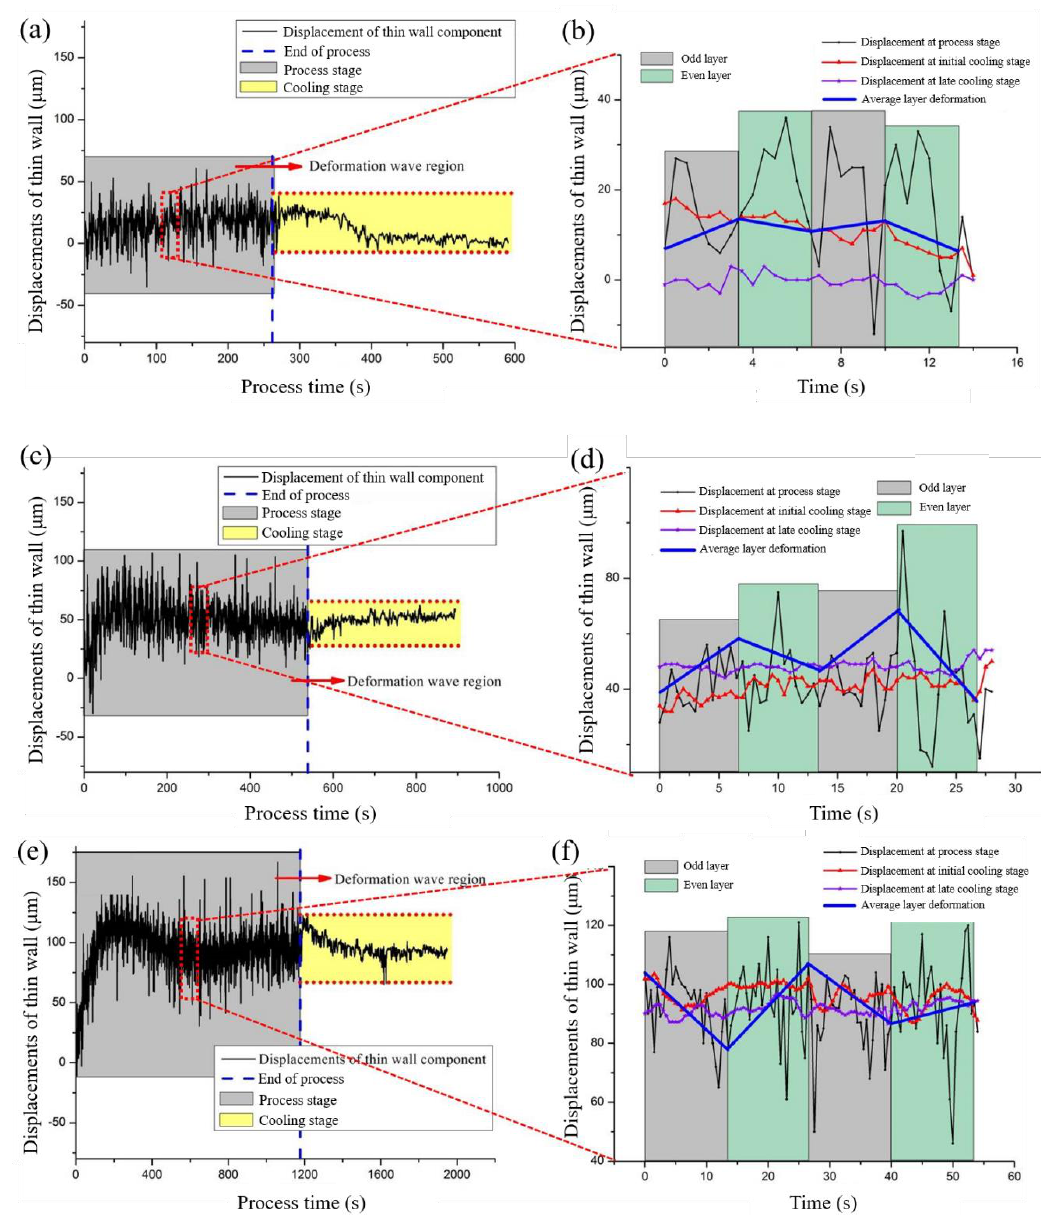
Figure 5. Real time deformation monitoring of the measured edge points on thin-wall samples with different lengths of: ( a,b ) 20 mm, ( c,d ) 40 mm, and ( e,f ) 80 mm.